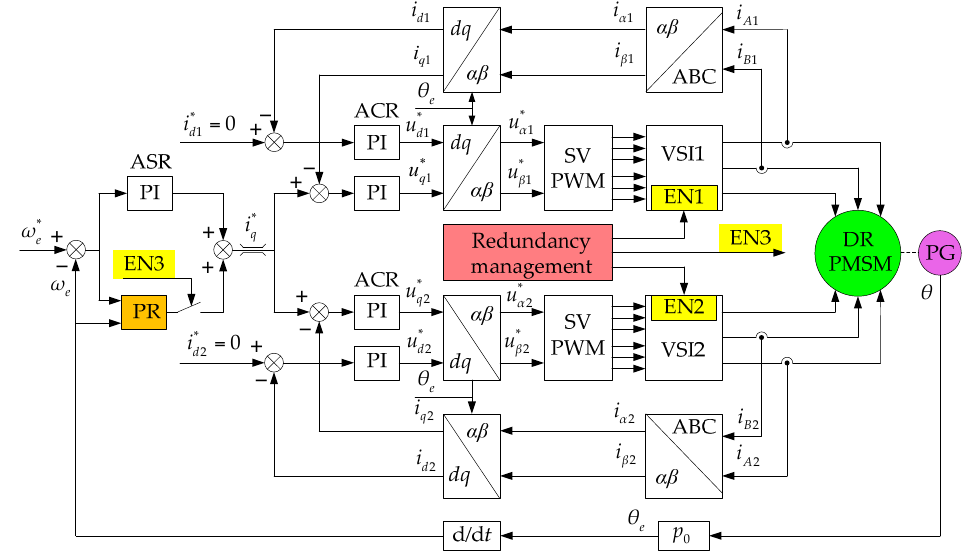
Figure 13. Control system of dual-redundancy permanent magnet synchronous motor based on PR.